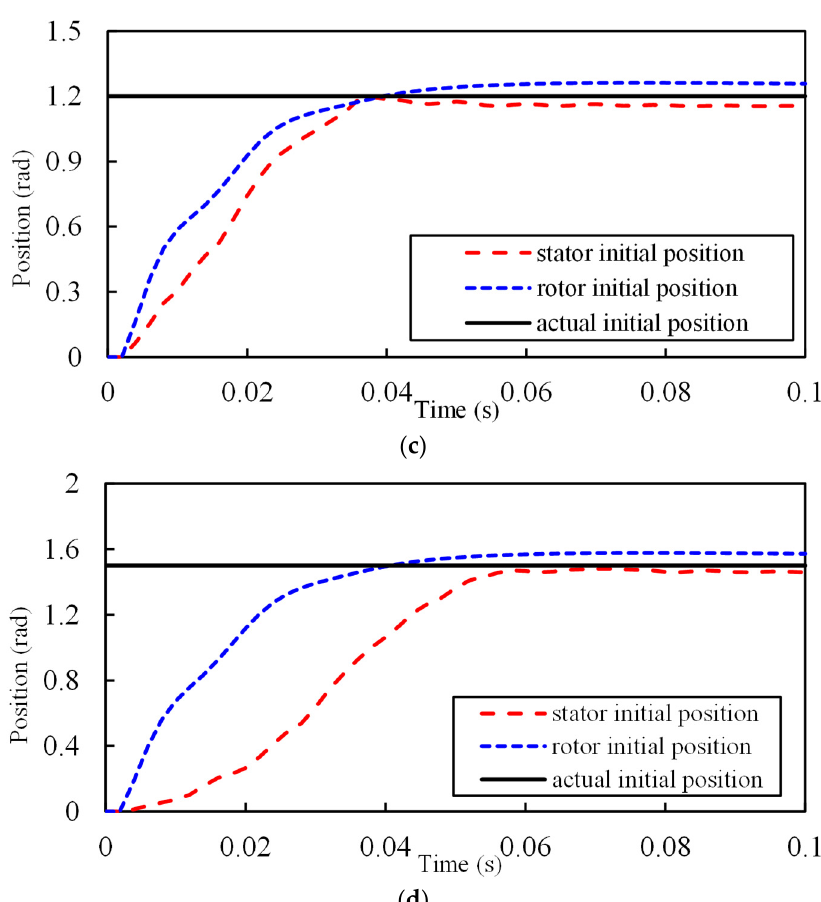
Figure 10. The initial position detection results. ( a ) The actual initial is 0.4 rad. ( b ) The actual initial is 0.8 rad. ( c ) The actual initial is 1.2 rad. ( d ) The actual initial is 1.5 rad.